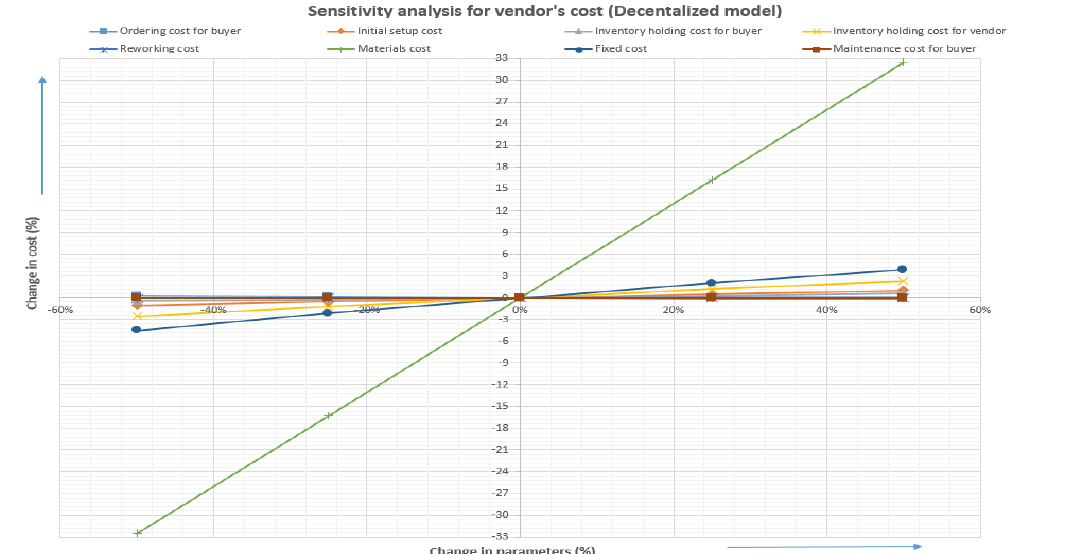
Figure 4. Sensitivity analysis: vendor’s cost versus change in parameters under decentralized model.